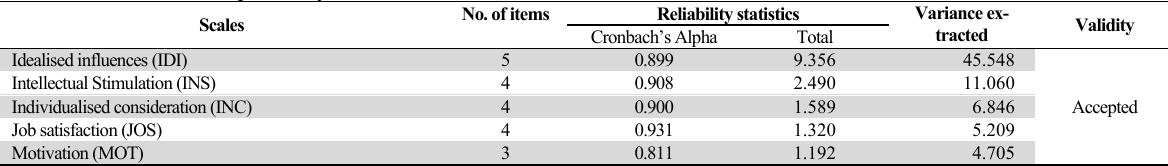
Results of Cronbach’s Alpha